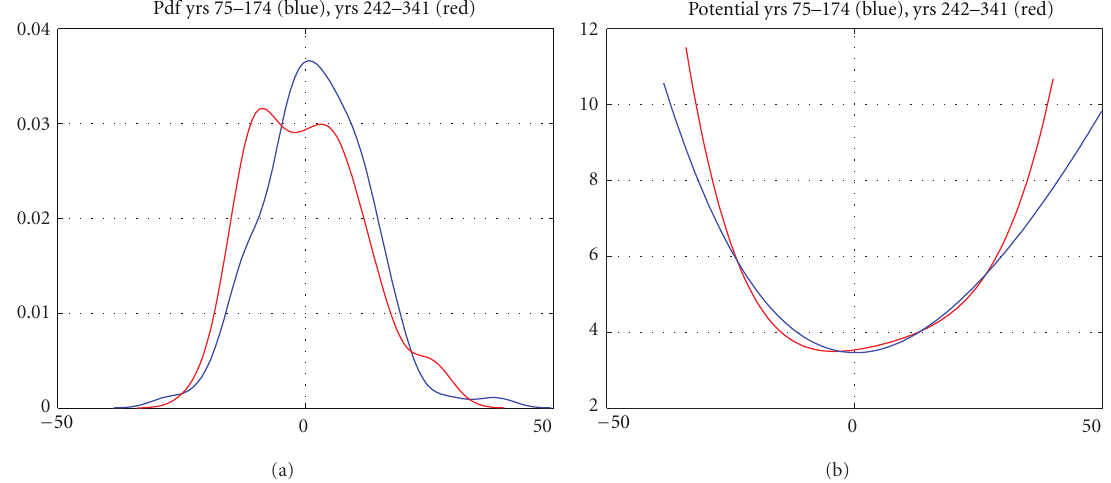
Figure 4: pdfs (a) and potential (b) of the time series of EOF1 for the preindustrial run during period P1 (years 75–174, blue) and period P2 (years 242–341,